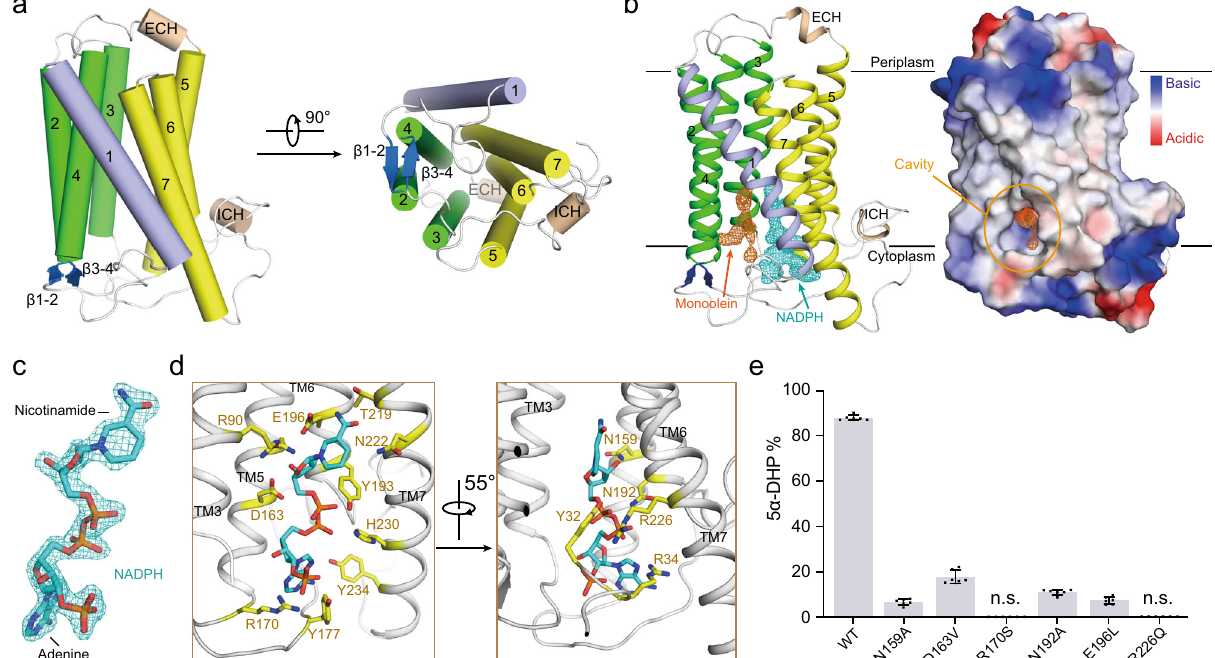
Fig. 2 The crystal structure of PbSRD5A and coordination of NADPH. a The overall structure of PbSRD5A. Two perpendicular views are shown. The seven transmembrane segments are divided into TM1 (lightblue), TM2-4 (green), and TM5-7 (yellow). The extracellular and intracellular short alpha helices (ECH and ICH) are colored wheat. The short antiparallel beta strands are colored blue. The loop regions are colored white. b 2Fo-Fc map for monoolein (orange mesh) and NADPH (cyan mesh) are both contoured at 1.0 σ . The two black lines show the approximate location of the lipid bilayer. The cavity is circled in an electrostatic surface representation. c NADPH fi ts into the density map shown in b . Nicotinamide and adenine groups are labeled. d Coordination of NADPH by polar residues of PbSRD5A. The residues that are hydrogen-bonded to NADPH are shown in yellow sticks. e Functional validation of residues coordinating NADPH in PbSRD5A. Enzyme activities were measured by the percentage of 5 α -DHP reduced from [ 3 H]-labeled progesterone in vitro within 1 h detected by HPLC. Data are mean±s.d. derived from technically independent experiments in duplicate. Each experiment was reproduced three times on separate occasions with similar